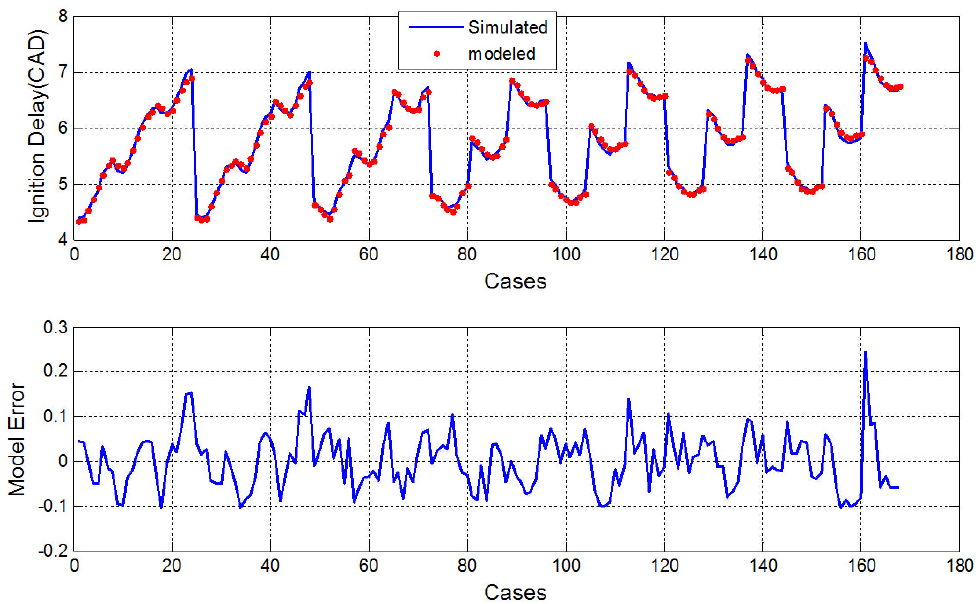
Figure 4. Comparison between the modeled and simulated ignition